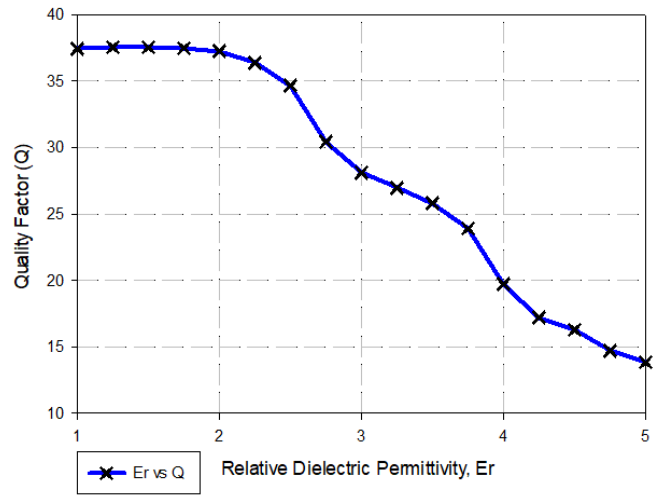
Figure 18. Plotted graph of relative permittivity vs. Q -factor.